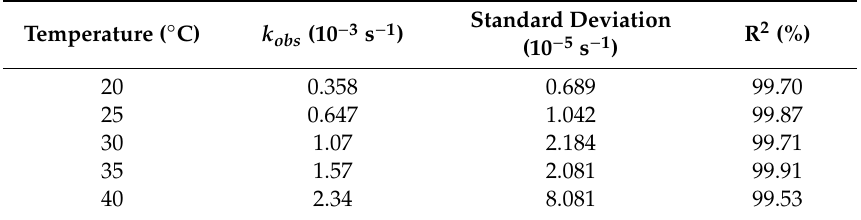
Figure 12. ( A ) ln([Rh B] / [Rh B] 0 ) as a function of reaction time at di ff erent temperatures (20–40 ◦ C) Figure 12. ( A ) l n([Rh B]/[Rh B] 0 ) as a function of reaction time at different temperatures (20–40 °C) in in the presence of 1 g / L of the Cu / Al 2 O 3 / CN composite. Reaction conditions: [Rh B] 0 = 20 mg / L, the presence of 1 g/L of the Cu/Al 2 O 3 /CN composite. Reaction conditions: [Rh B] 0 = 20 mg/L, [H 2 O 2 ] 0 = [H 2 O 2 ] 0 = 10 mM, V = 100 mL, pH 4.9 (unadjusted). ( B ) ln( k obs ) as a function of 1 / T. The k obs values are 10 mM, V = 100 mL, pH 4.9 (unadjusted). ( B ) ln( k obs ) as a function of 1/T. The k obs values are obtained obtained from Figure 12A. from Figure 12A. Table 3. The key parameters of the fitted curves in Figure Table 3. The key parameters of the fitted curves in Figure 12A.